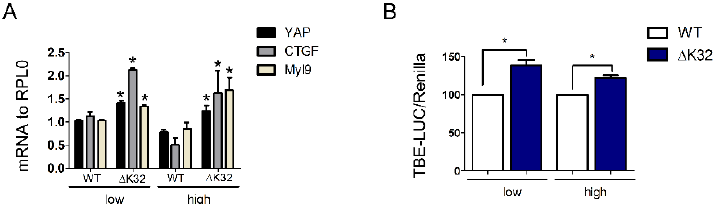
Figure 5. Transcriptional activity of YAP. ( A ) Histogram represents mRNA transcripts of YAP , CTGF , and Myl9 normalized to RPLP0 and expressed as fold-changes. Values are ± SEM, n = 3 separate experiments. * p < 0.05 compared with WT. ( B ) Quantification of YAP activity using the TBE-Luciferase (LUC) / Renilla reporter. Values are ± SEM, n = 3 separate experiments. * p < 0.05 compared with WT cells.